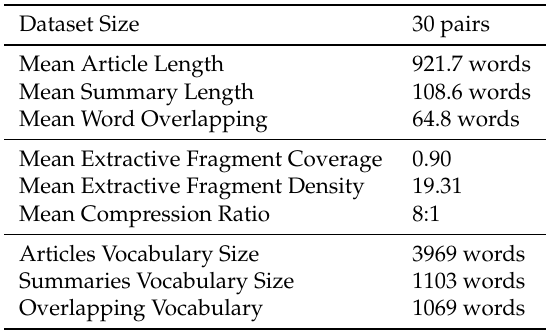
Table 2. LN24-SUMM corpus